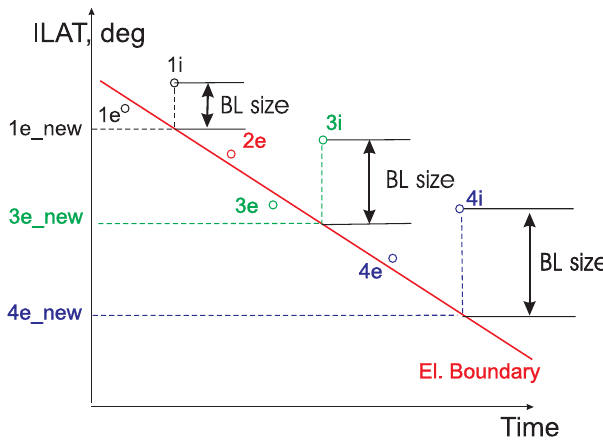
Fig. 4. Illustration of the multi-spacecraft method used in this pa- per, showing a plot of invariant latitude versus time. Points marked as 1e , 2e , 3e and 4e indicate 4 measurements of invariant latitude of the observed electron boundary of the LLBL/cusp at different times made by SC 1, 2, 3 and 4, correspondingly. Points 1i , 3i and 4i indicate 3 measurements of invariant latitude of the observed ion boundary of the LLBL/cusp at different times made by SC1, 3 and 4 correspondingly. The red line represents the position of the elec- tron boundary as a function of time reconstructed from the linear least squares fit to the four measurements 1e , 2e , 3e , and 4e . Points marked as 1e new , 3e new and 4e new represent reconstructed in- variant latitudes of the electron boundary the times when the Cluster satellites detect the ion boundaries 1i , 3i and 4i